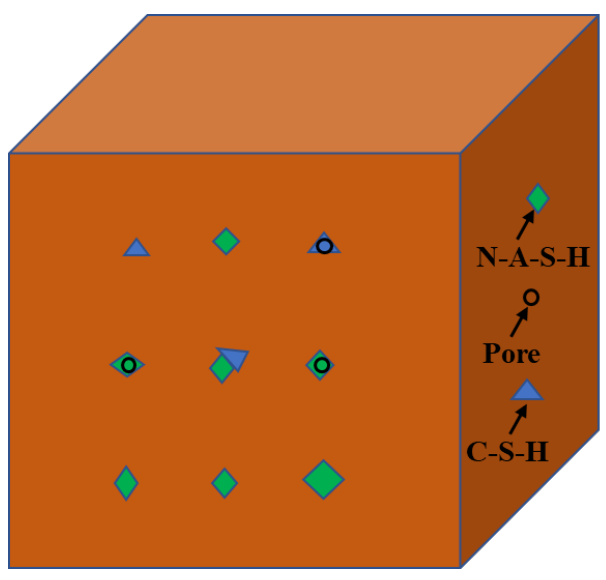
Figure 3. The co-existence of C-S-H gel and N-A-S-H gel in the